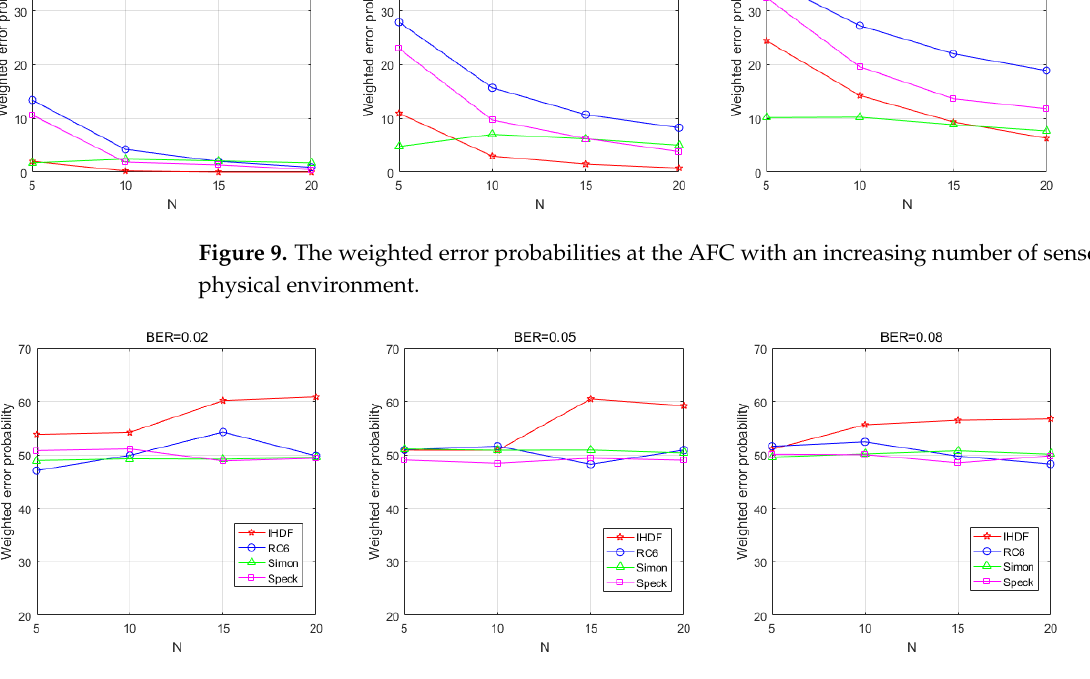
Figure 10. The weighted error probabilities at the EFC with an increasing number of sensors in the physical environment.